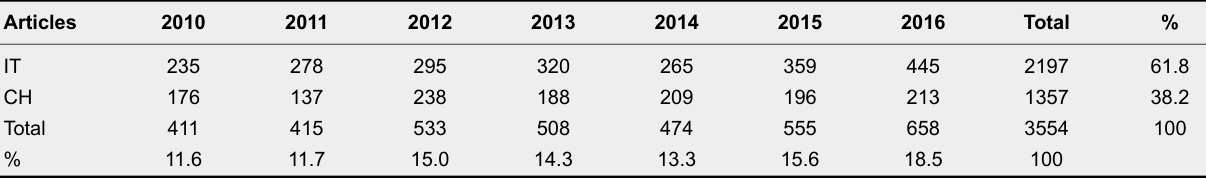
Corpus (Number of Articles) of Retrieved Articles for Lexicographical Analysis by Year